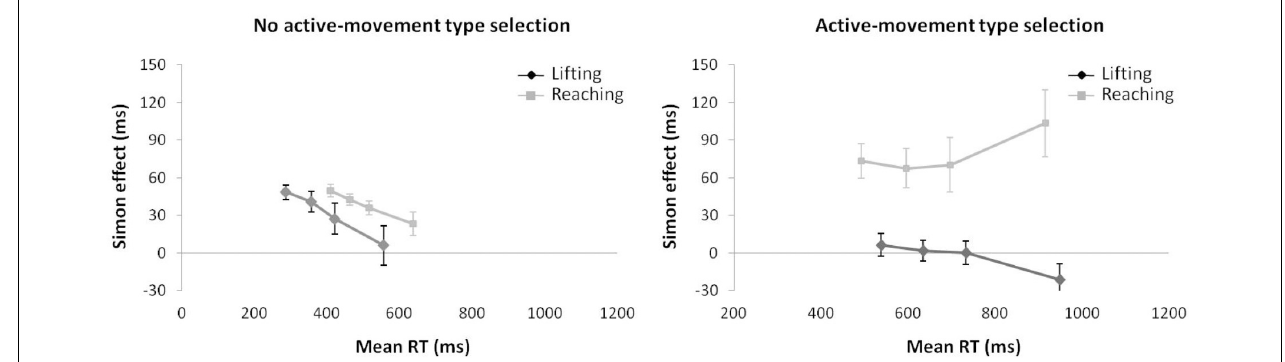
FIGURE 7 | Delta-plots showing Simon effect magnitudes as a function of response speed (expressed in reaction time quartiles) for lifting and reaching actions within the no active-movement type selection condition (left side) and active-movement type selection (right side) in Experiment 3. Error bars represent the standard error of the mean.